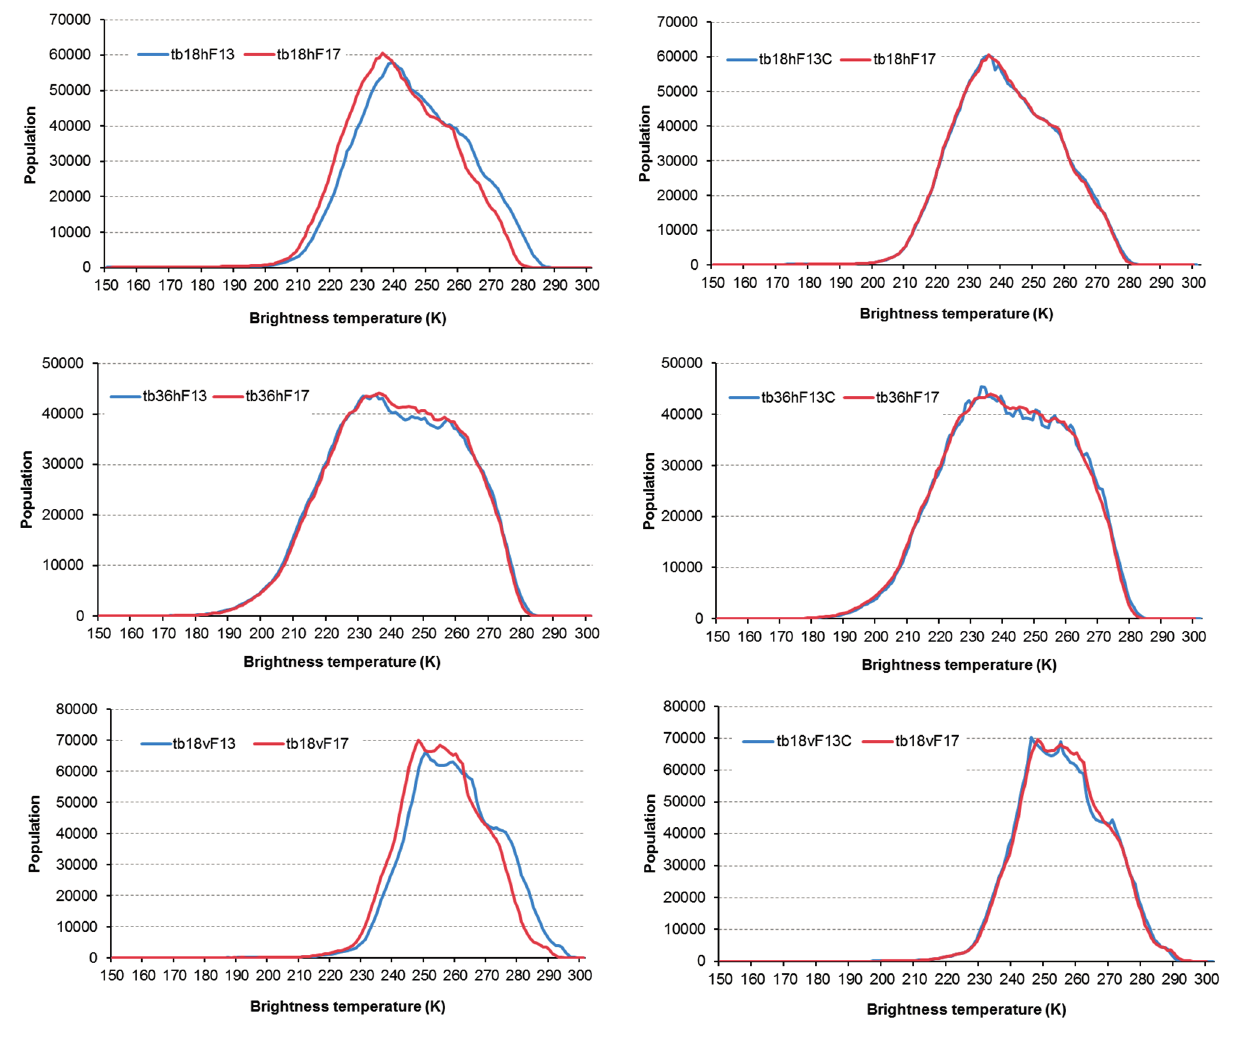
(Figure 2). The correlation coefficients between the brightness temperatures from F13 and F17 and from F13C and F17 were computed, respectively. The brightness temperature histograms depicted the number of pixels (population) at every brightness temperature in steps of 1 K during the overlap period. The results indicate that the plot of the vertical polarization matched better than that of the horizontal polarization (Figure 2). The correlation coefficients between populations from F13 and F17 at the 18H, 36H, 18V, 36V and 22V channels improved from 0.9763 to 0.9997, from 0.9987 to 0.9989, from 0.9733 to 0.9982, from 0.9965 to 0.9970, and from 0.9853 to 0.9972, respectively. Therefore, the consistency of the brightness temperature between F13 and F17 can be substantially improved through inter-sensor calibration. The consistency of the SCA and snow depth derived from these sensor data are evaluated in Section